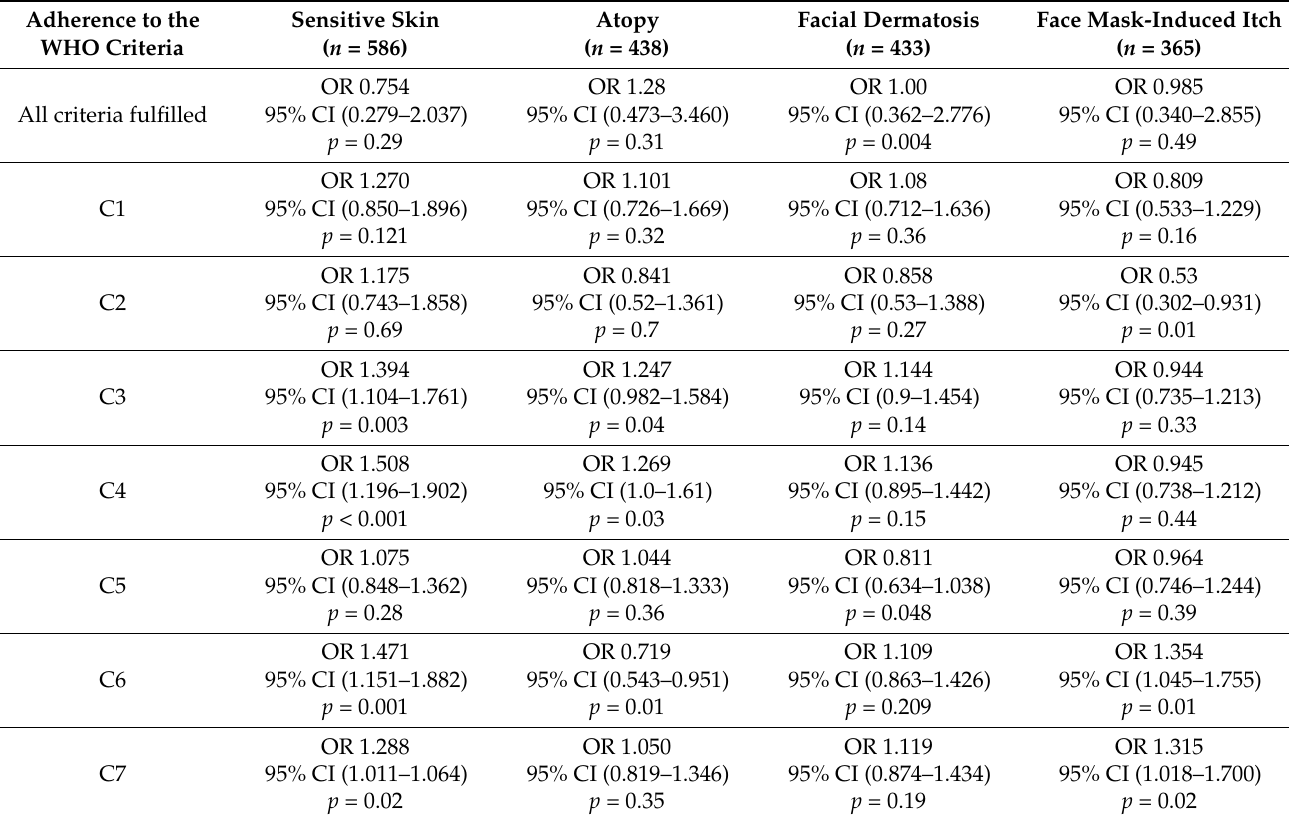
Table 6. Logistic regression parameters concerning the influence of skin-related conditions on the fulfilment of the WHO criteria as an